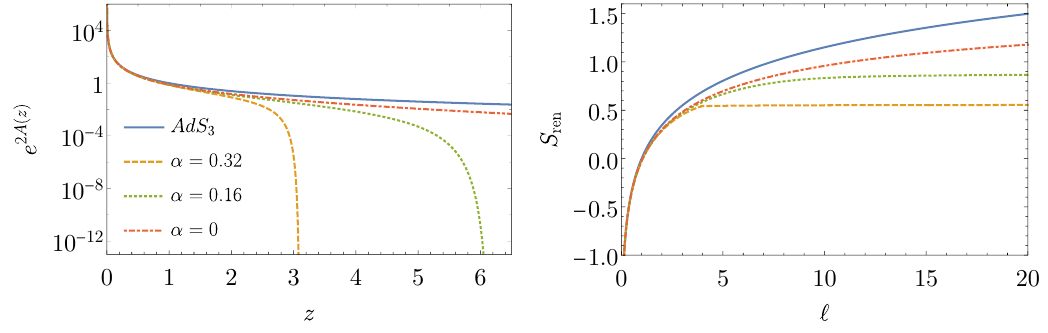
Figure 5 . Left: scale factor in domain wall geometry (3.8) for different potentials. Right: renor- malized EE for four cases in left